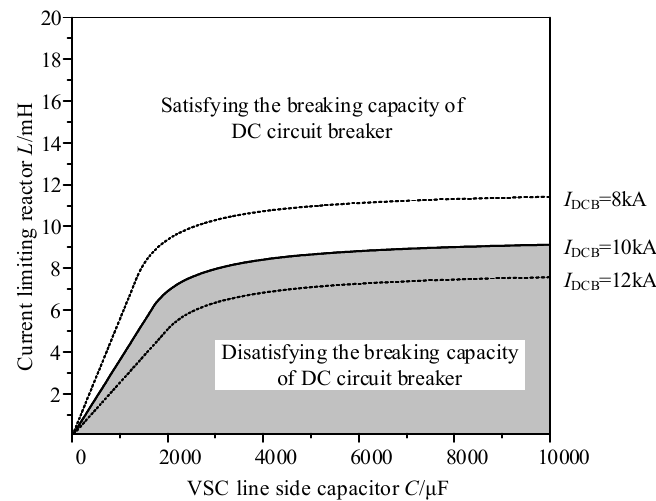
Figure 8. Relationship between DC circuit breaker breaking capacity I DCB and VSC capacitor C , current limiting reactor L (VSC) .